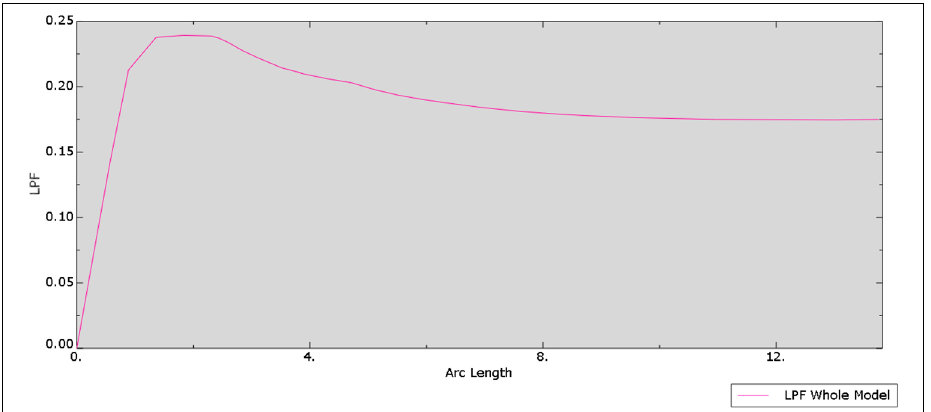
0.239 × 400 = 95.6 MPa.